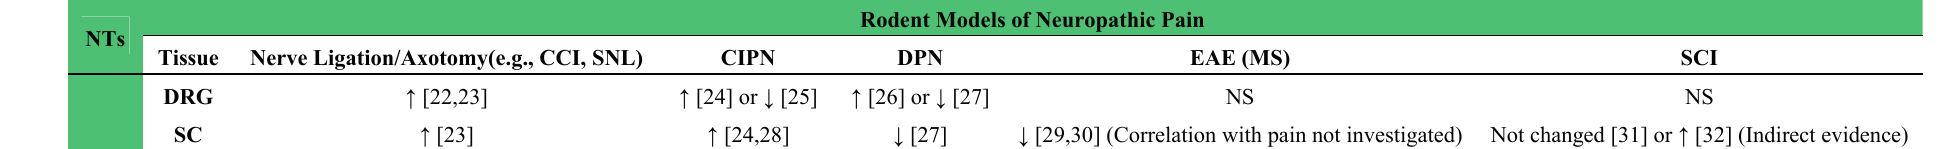
Table 1. Expression of neurotrophins and their nociceptive role in rodent models of neuropathic